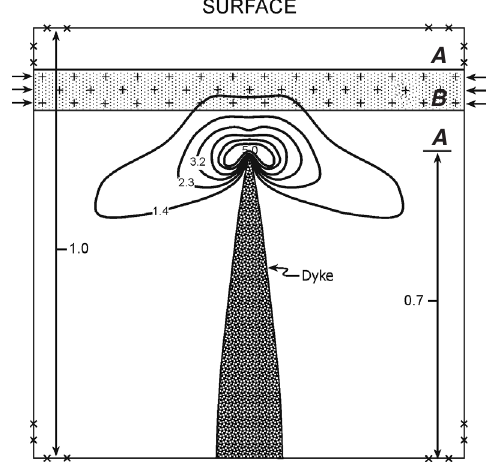
Fig. 18. Boundary-element model showing the con- tours, in MPa, of the maximum principal tensile stress σ 3 around a dyke tip located at 3 km below the surface of a rift zone or a volcanic edifice. Layer B is a stress barrier with excess horizontal compressive stress of 7 MPa; this layer extends from a depth of 1 km to 2 km below the surface. The stiffnesses and Poisson’s ratios of layers A and B are uniform, 40 GPa and 0.25, respectively. The contours of σ 3 flat- ten out under the stress barrier and no dyke-induced tensile stresses reach the surface. In this and the models in figs. 19 and 20, the dyke thickness (open- ing), as obtained from the numerical models, is not to scale when compared with the crustal